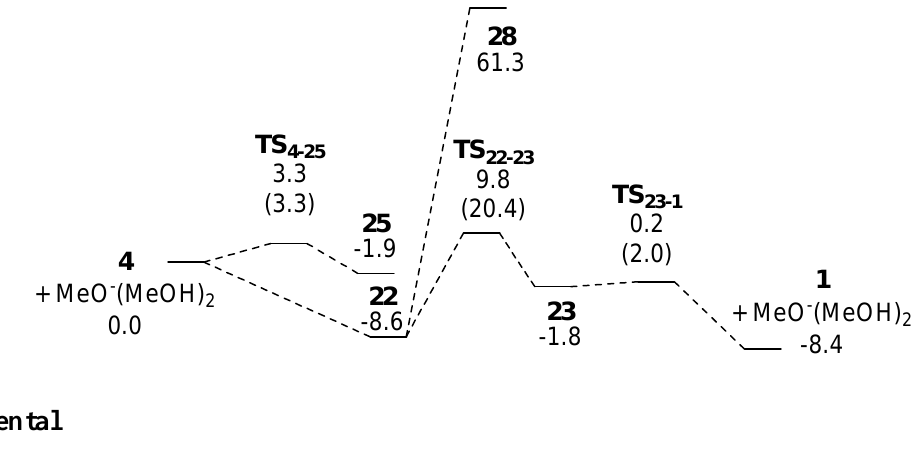
Figure 3. Energy correlation diagram (kcal mol -1 ) and structures related to the Michael reaction for the target 1